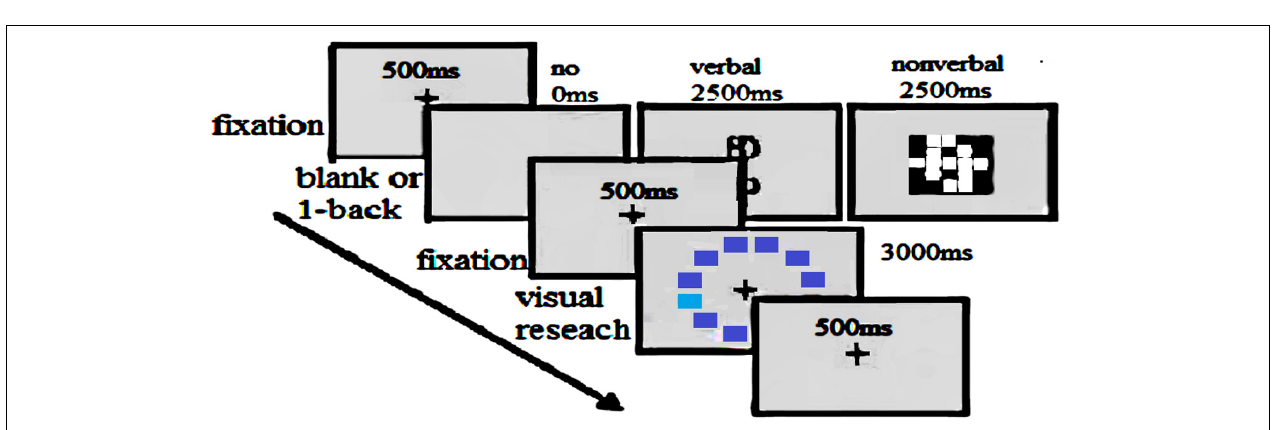
FIGURE 3 | For the visual search task, (A) a color categorical perception (CCP) for blue compared with green was shown in Mongolian, while (B) a CCP was not shown in Chinese (Mandarin). Error bars represent the mean with a 95% CI, ∗∗∗ p < 0.001, ANOVA, df = 62; ns, nonsignificant.